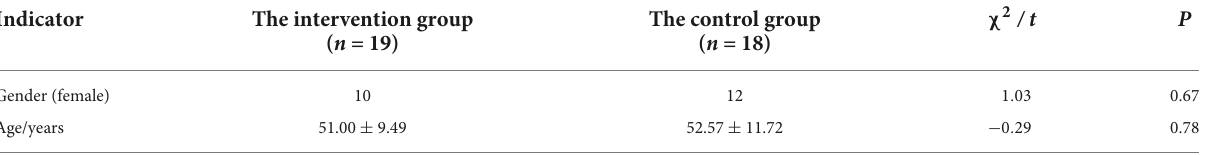
TABLE 1 Comparison of general information between the two groups of patients.